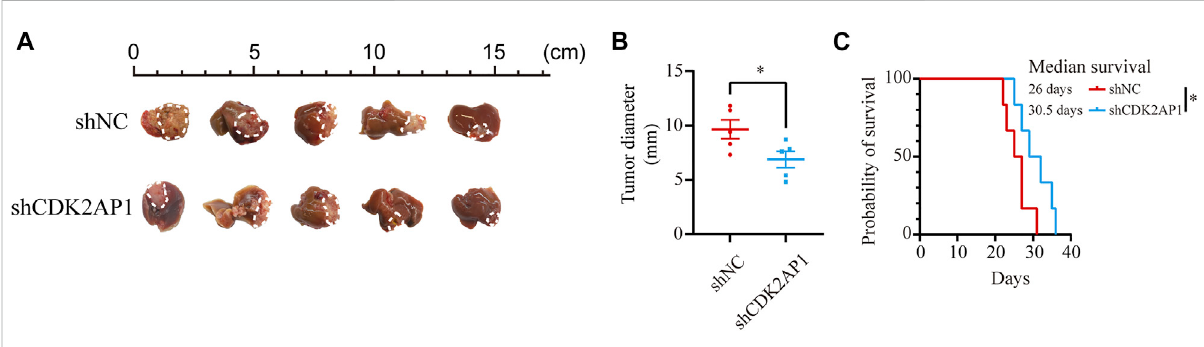
FIGURE 8 CDK2AP1 promotes tumor growth and decreases overall survival in vivo (A) Photographs of tumors in orthotopic tumor models (B) Tumor diameter of two groups was measured at the end of the experiment (C) The mice survival curves after tumor inoculation. * p < 0.05, ** p < 0.01 and *** p <